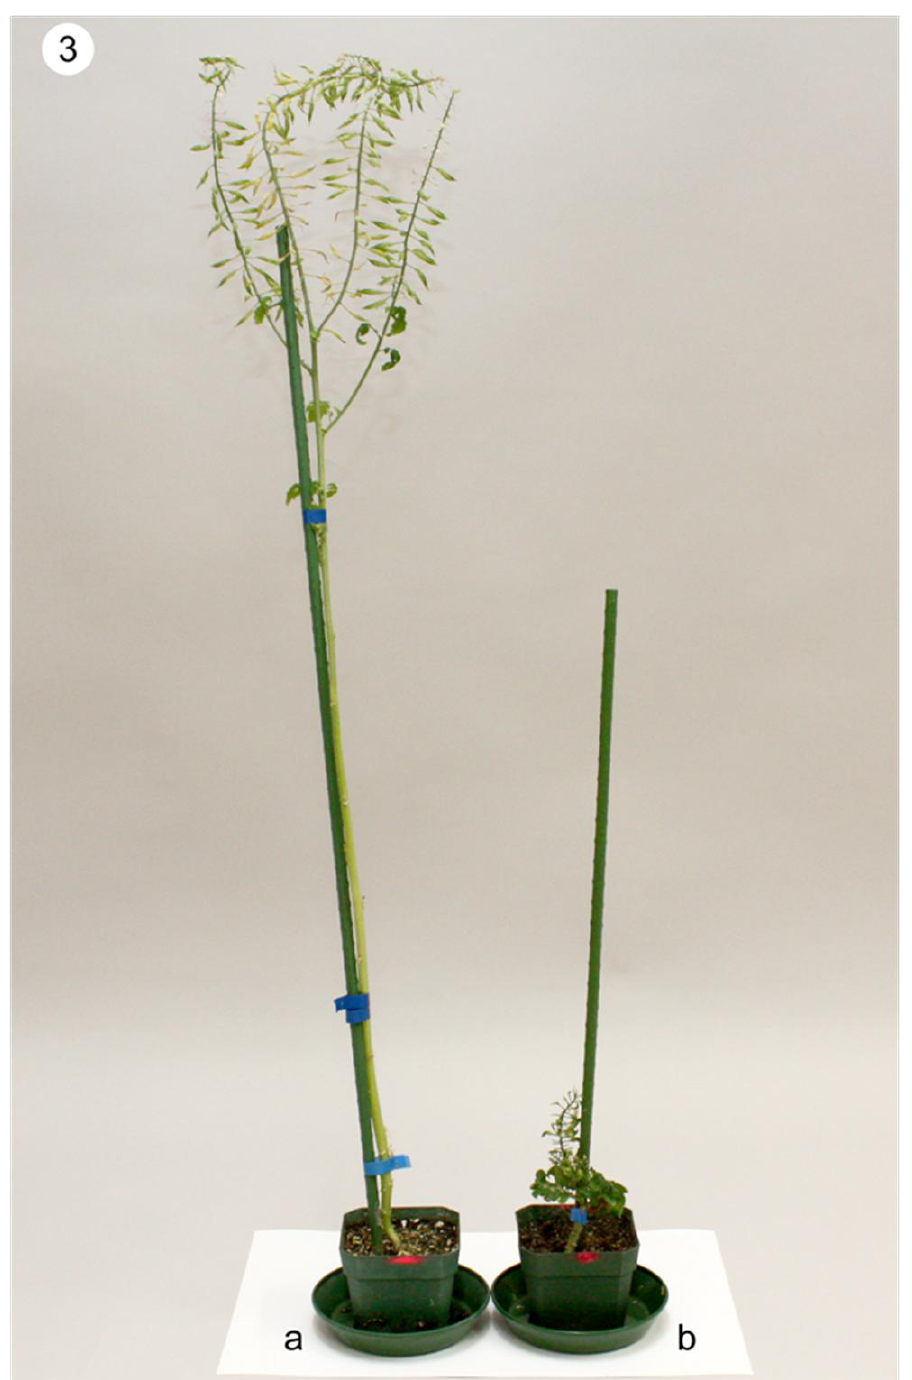
Figure 3. Normal and dwarf S2 plants of line Y665. ( a ) Normal S2 plant; ( b ) Dwarf S2